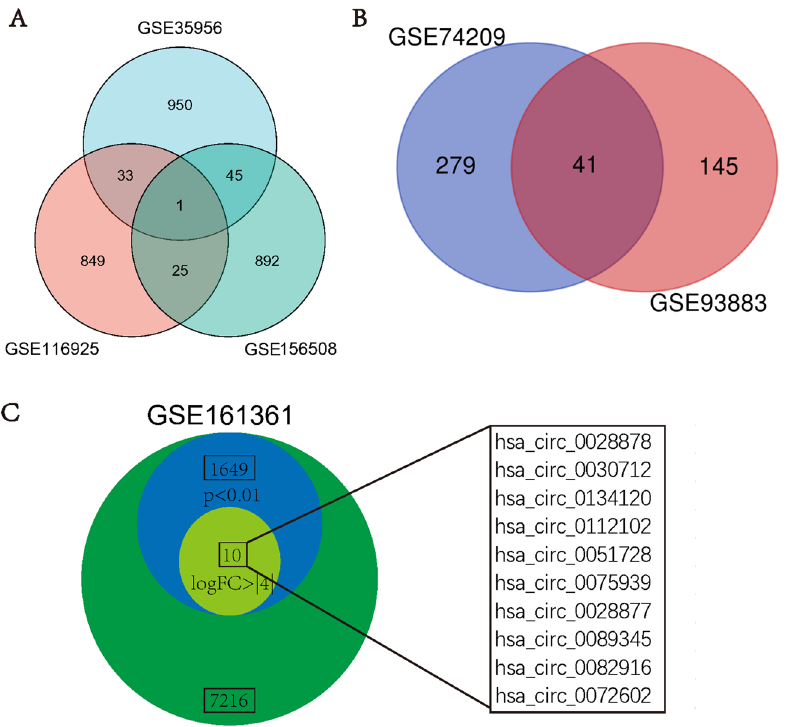
Figure 3. Identification of DEGs, DEMs, and DECs. ( A ) 104 DEGs were obtained from three GEO data sets, ( B ) 41 DEMs were obtained from three GEO data sets, ( C ) 10 DECs (also means target circRNAs) were obtained from GSE161361. DEGs, differentially expressed genes. DEMs, differentially expressed miRNAs. DECs differentially expressed circRNAs.